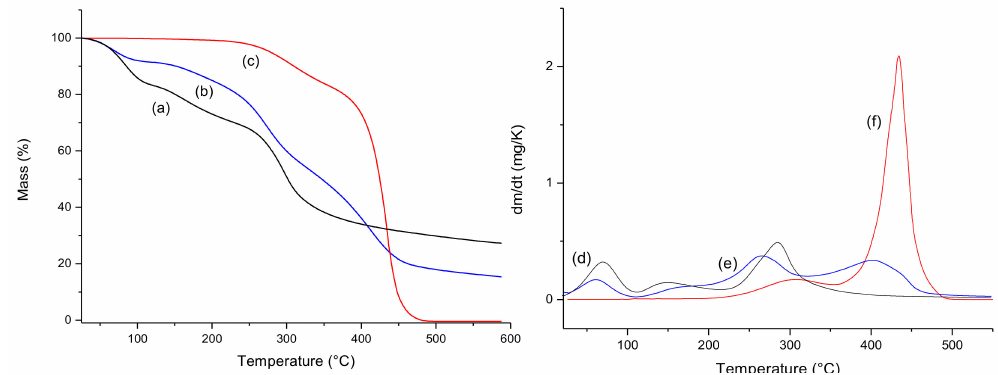
Figure 1. Thermogravimetric curves (TG) of pure chitosan gel (a), chitosan gel with buriti oil (b), and buriti oil (c), and Derivative Thermogravimetric curves (DTG) of chitosan gel (CG) (d), chitosan gel with buriti oil (e), and buriti oil (f).